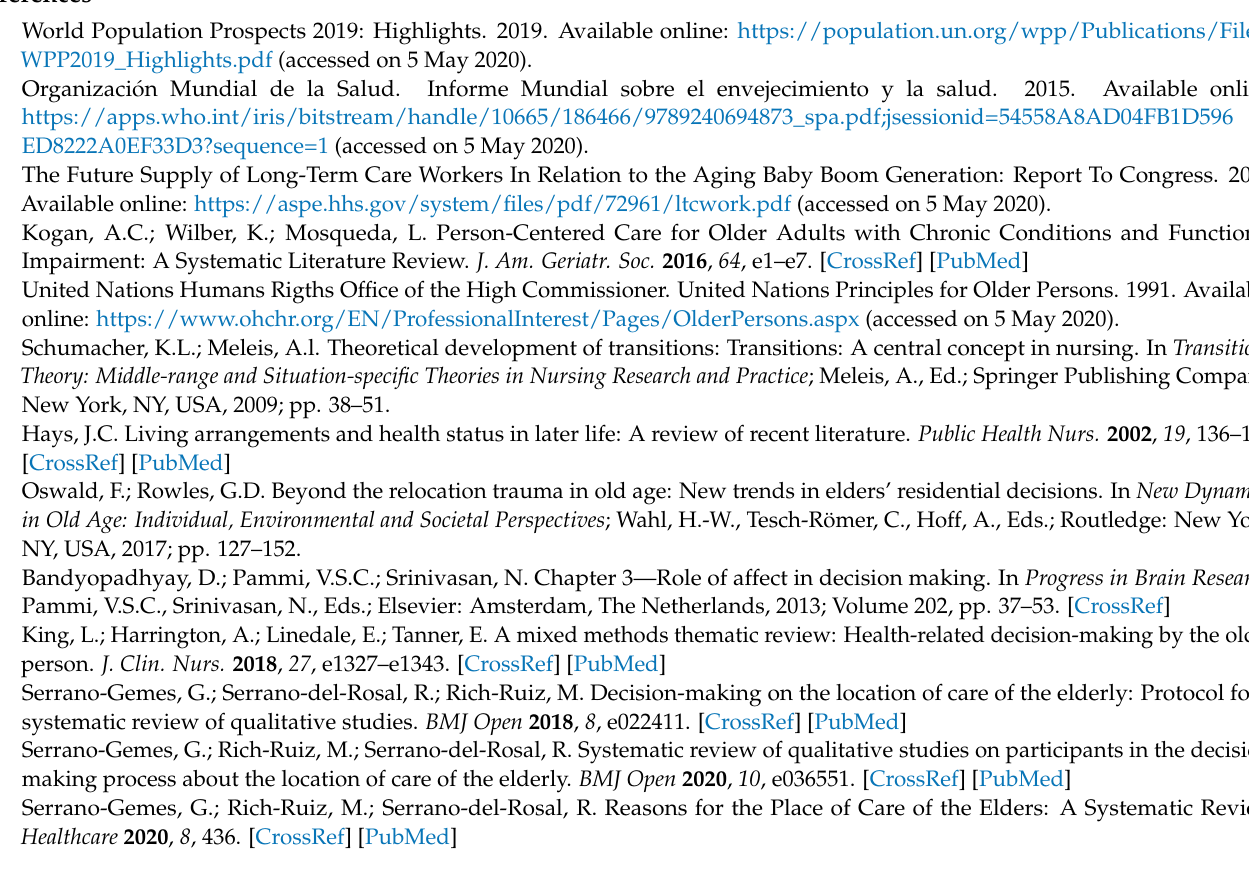
(Table S1: PRISMA Checklist); the second shows a table with the characteristics of the included studies (Table S2: Characteristics of the included studies); the third shows different summary tables with all the experiences found in our review (Table S3: List of experiences); the fourth is a document that shows textual quotes that support our results (Text S4: Original